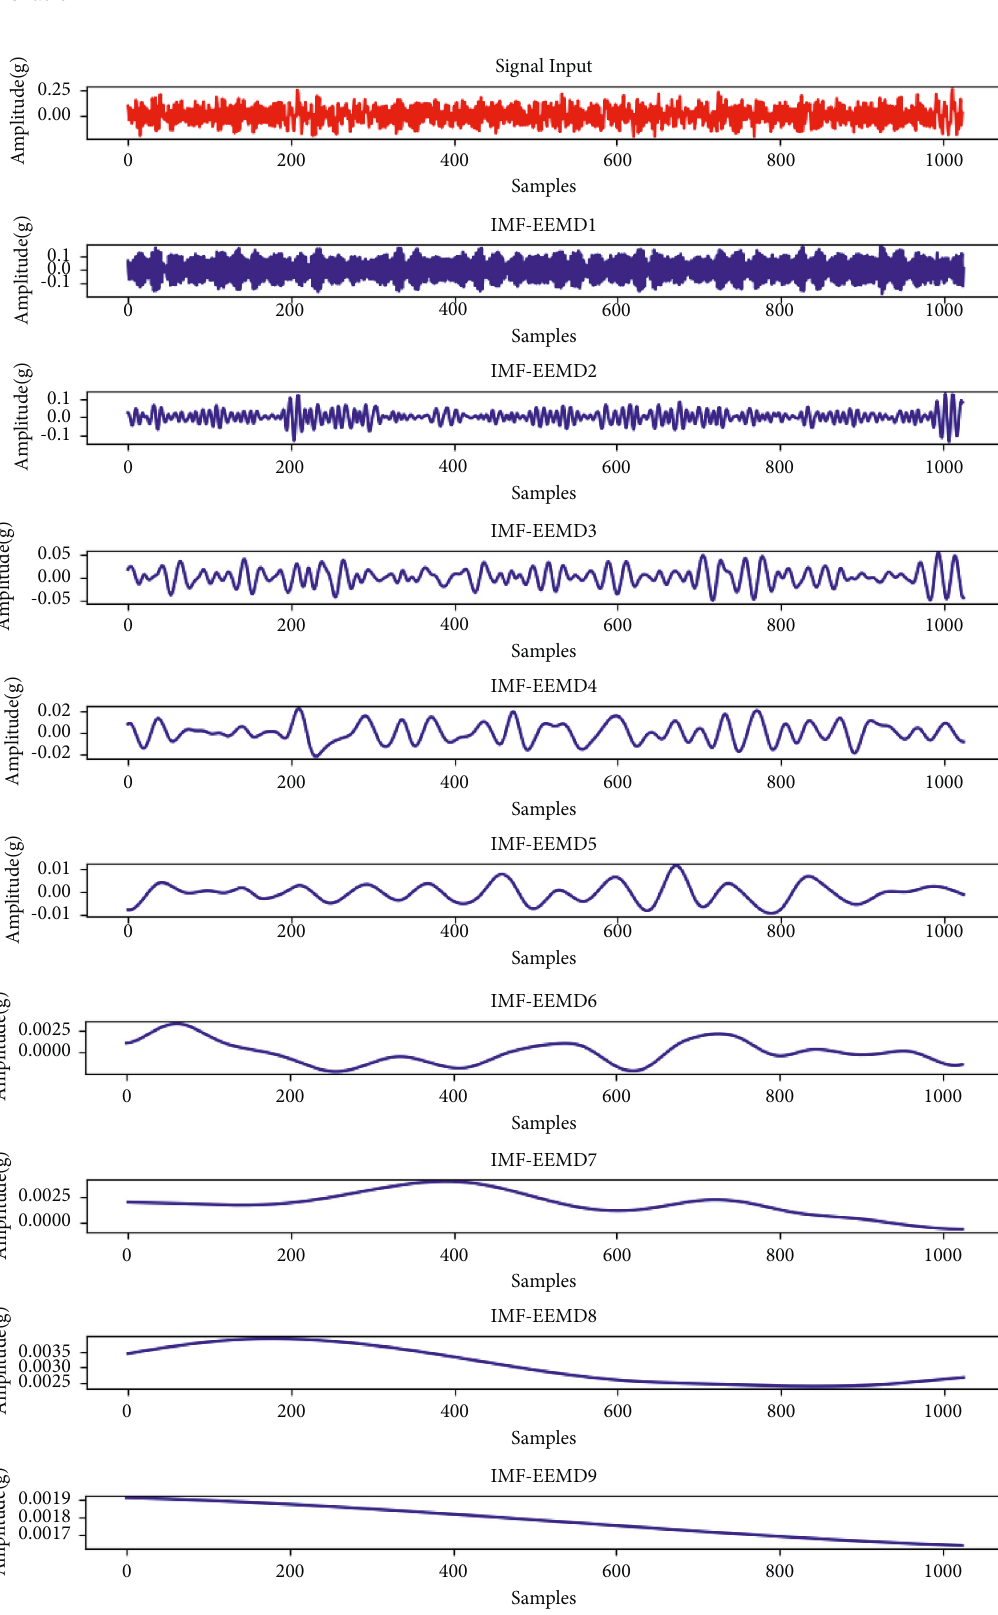
Figure 3: EEMD decomposition